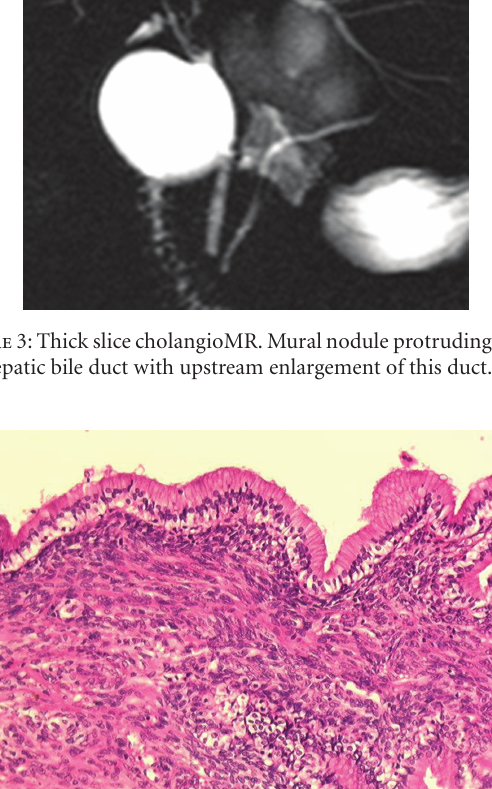
Figure 4: Mucinous cystadenoma with mesenchymal stroma: mu- cus-secreting epithelium resting on a stroma rich in mesenchymal